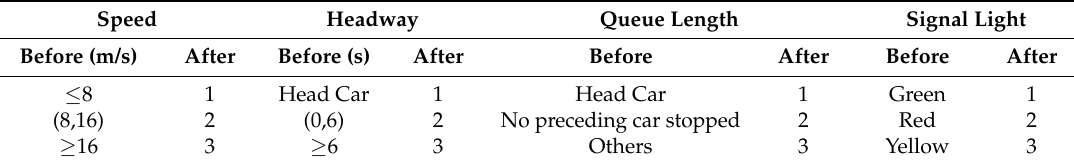
Table 2. Rules of data discretization.